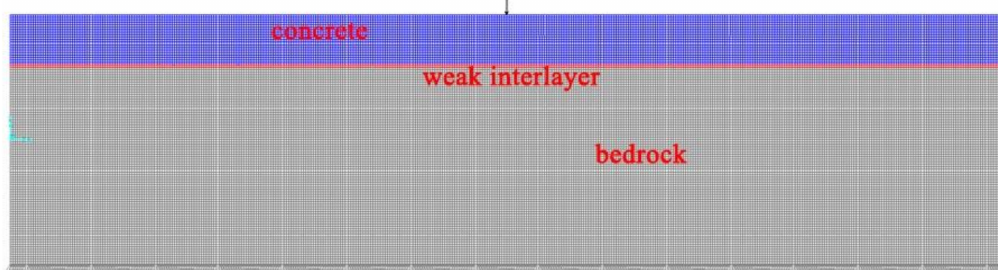
Figure 4. Numerical model and schematic layout of impact and receivers.